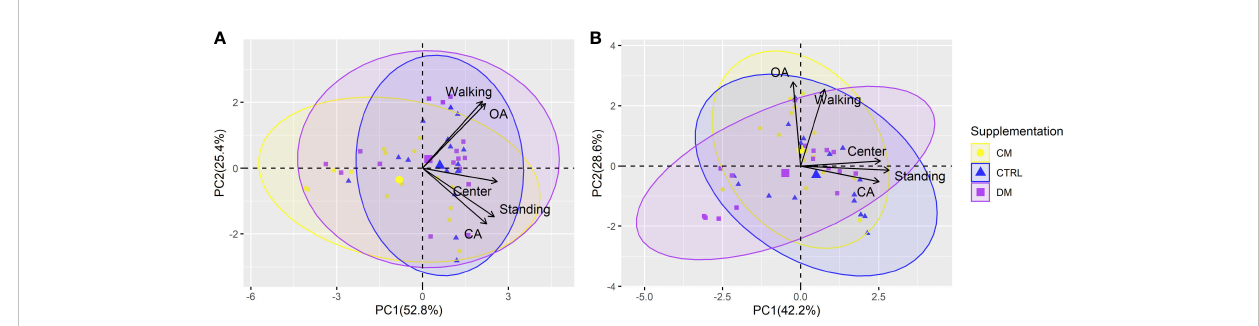
FIGURE 7 Principal component analysis (PCA) of the piglet ’ s behavior in the elevated plus maze test before (A) and after (B) weaning (n = 48) submitted to three supplementations: DM (Asinine milk), CM (Cow skimmed milk) and CTRL (Control without supplementation). Behaviors: OA (open arms), CA (closed arms), Center, Standing and Walking. Ellipses indicates the region with 95% con fi dence of the data for each treatment.